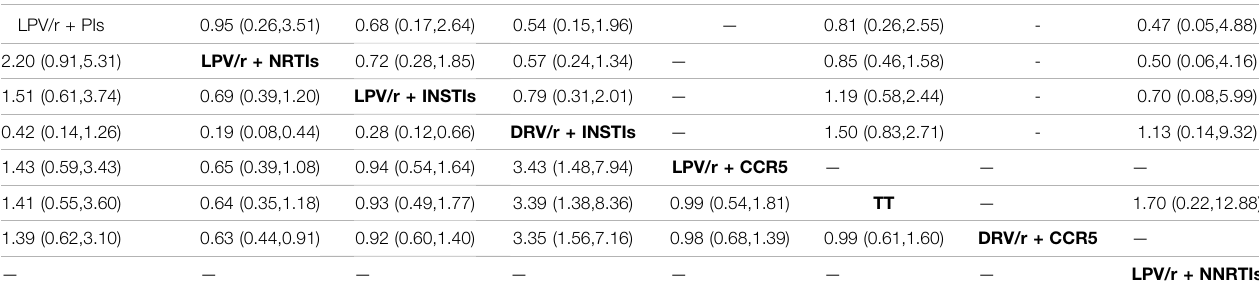
TABLE 2 | Cell Counts from Baseline Meta-analysis Results of Viral Suppression Rate (upper right corner) and Adverse Events (lower left corner) ( OR value and 95% CI ). LPV/r +